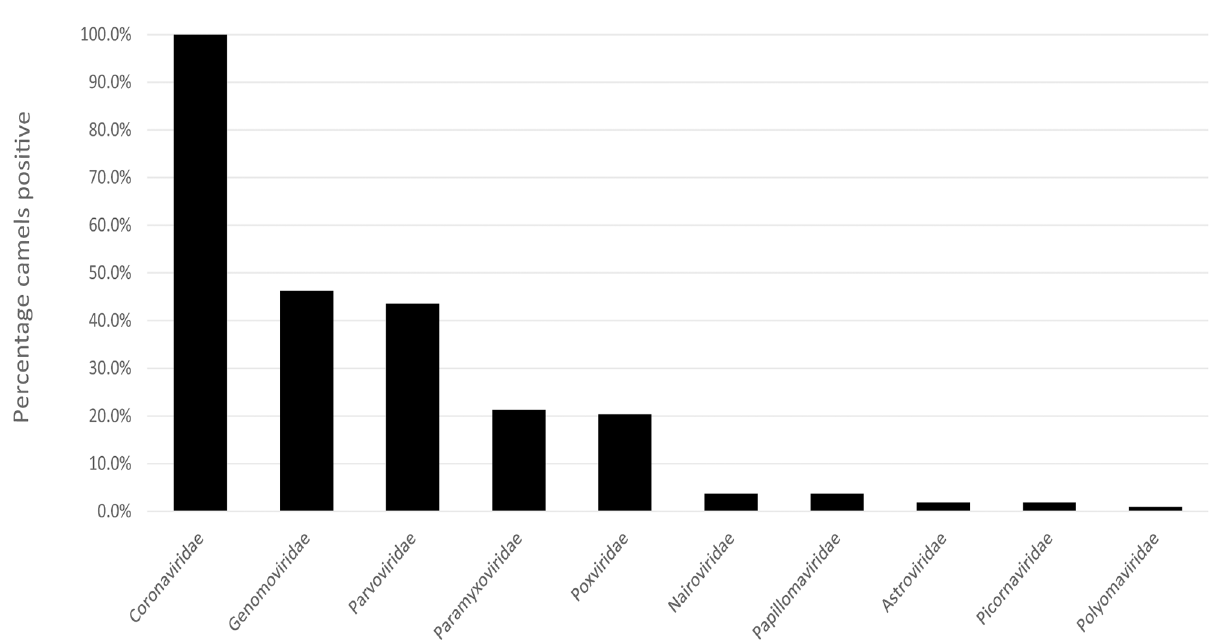
Fig 1. Prevalence of mammalian virus families identified in camelsfrom a single live animal market in Abu Dhabi in the United Arab Emirates(UAE). The percentageof camels that were positive for each viral family is depictedby the bar graph.